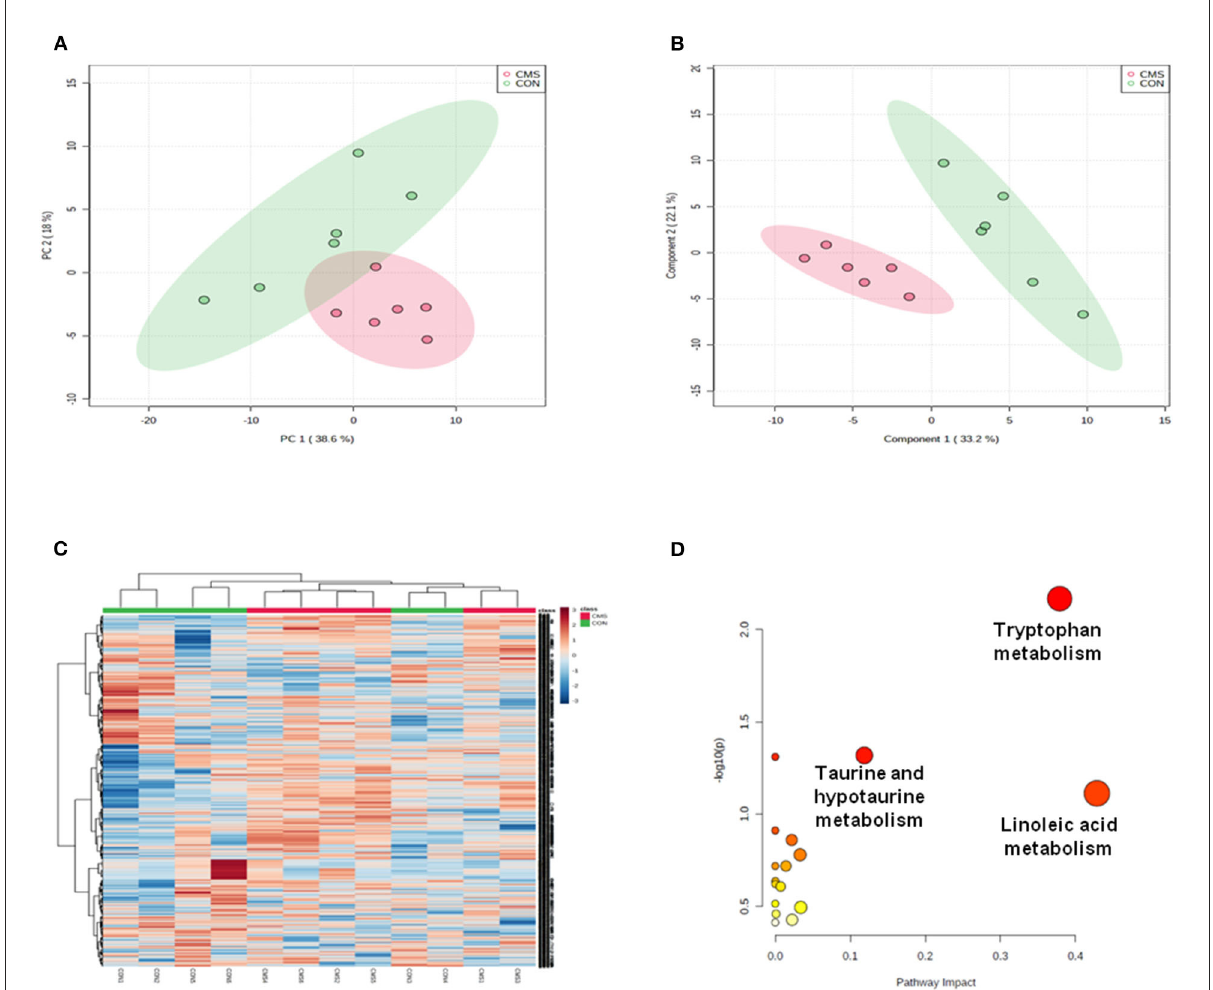
FIGURE3 Multivariate statistical analysis and metabolic pathway analysis. (A) Principal component analysis (PCA) scores plot derived from LC/MS of the chronic mild stress (CMS) and healthy control (CON) groups. (B) Pair-wise orthogonal projections to latent structures discriminant (OPLS–DA) scores plot derived from LC/MS of the CMS and CON groups. (C) Clustering analysis for the differential metabolites. (D) Pathway analysis; a, tryptophan metabolism; b: linoleic acid metabolism; c: taurine and hypotaurine metabolism. n =